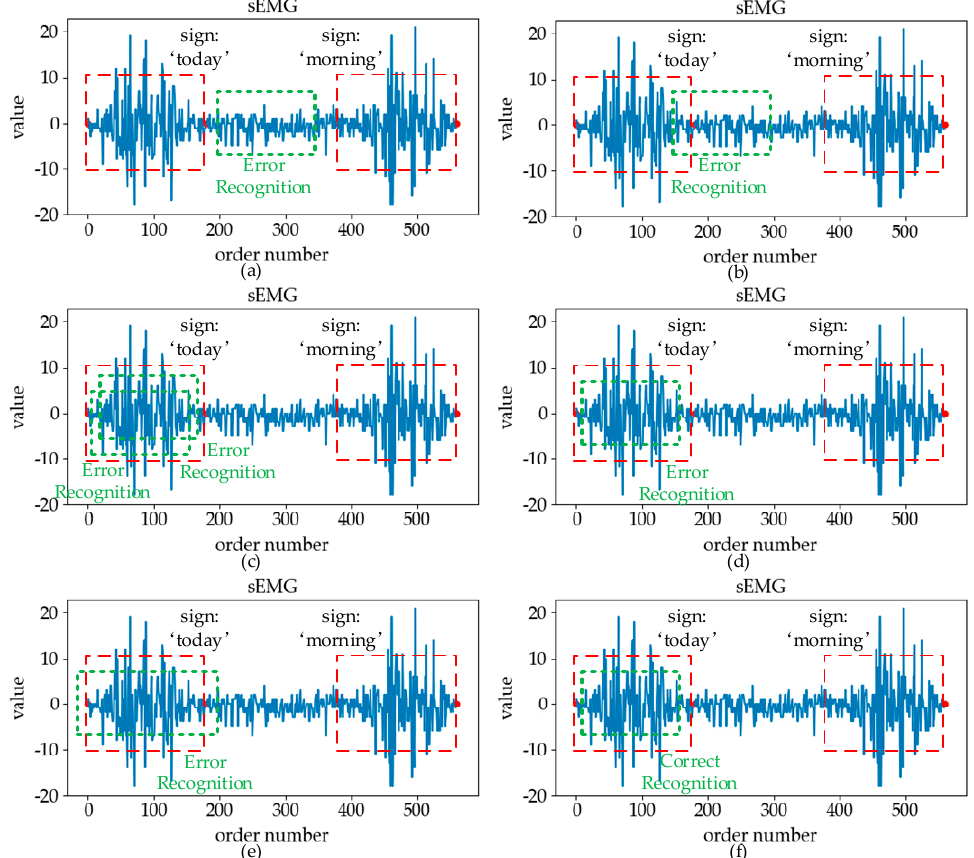
Figure 2. Situations in online sign language recognition (SLR): ( a ) insert; ( b ) misalignment; ( c ) repeat; ( d ) substitute; ( e ) delete; ( f ) correct. The red box indicates the effective region of sign language action, and the green box indicates the position of the recognition results, including correct recognition and misrecognition. ( a – e ) are misrecognition in online SLR and ( f ) is correct recognition.